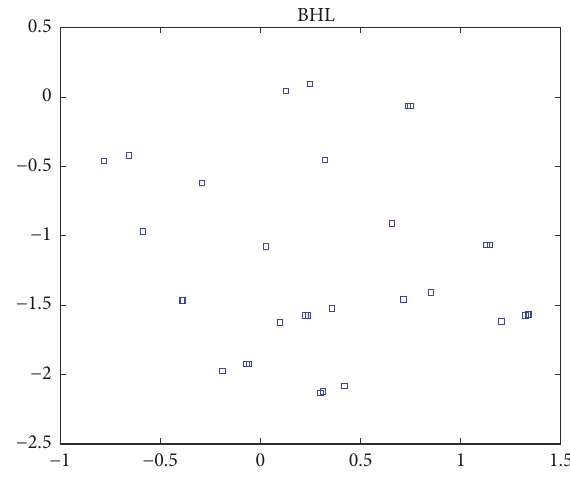
Figure 2: BHL: Projection of malware